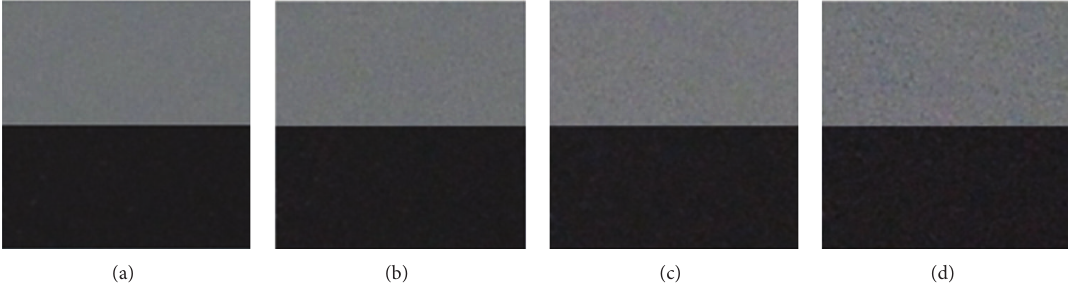
Figure 2: Visual noise comparison for pictures captured by thesame camera Nikon D7000 under thesame scenery with different ISO settings: